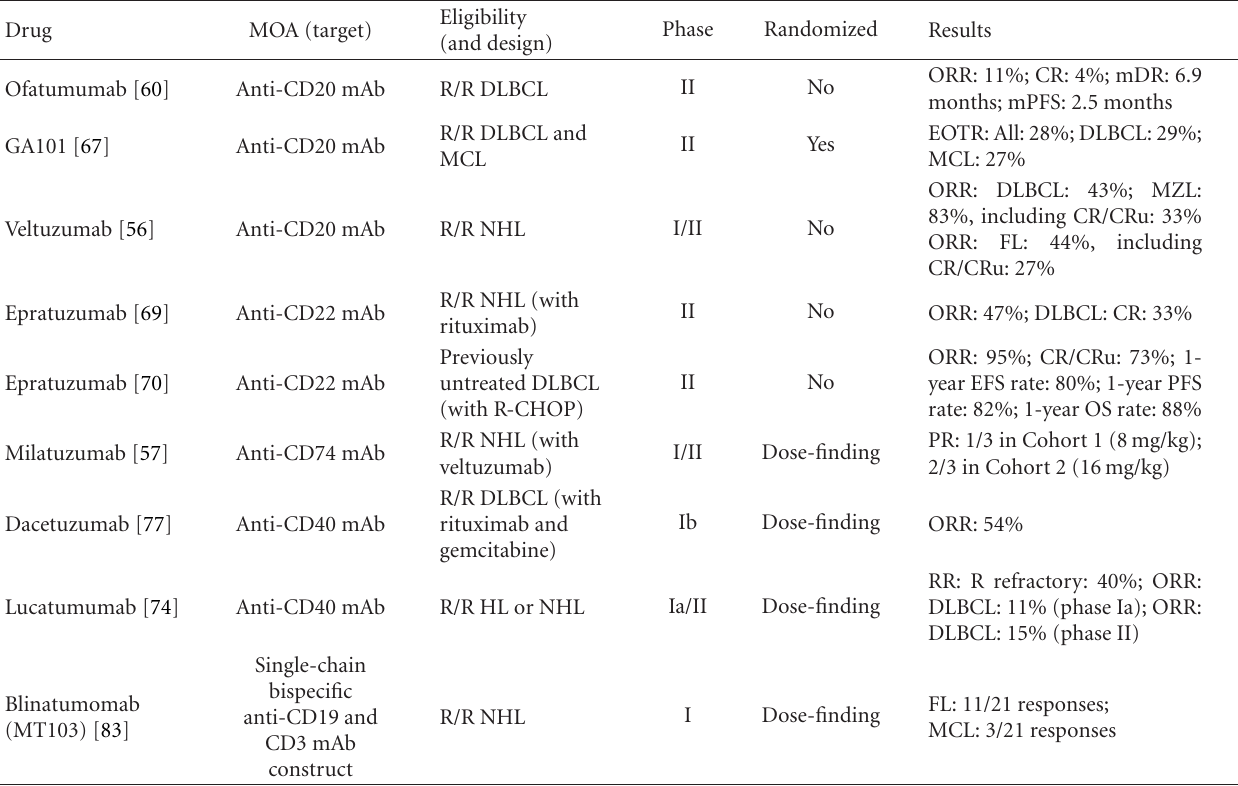
Table 2: Therapeutic antibodies in clinical development for the treatment of aggressive NHL. [CR: complete response; CRu: unconfirmed CR; DLBCL: di ff use large B-cell lymphoma; EFS: event-free survival; EOTR: extent of tumor resection; FL: follicular lymphoma; HL: Hodgkin lymphoma; mAb: monoclonal antibody; MCL: mantle cell lymphoma; mDR: median duration of response; MOA: mechanism of action; mPFS: median progression-free survival; MZL: marginal zone B-cell lymphoma; NHL: non-Hodgkin lymphoma; ORR: overall response rate; OS: overall survival; PFS: progression-free survival; PR: partial response; R-CHOP: cyclophosphamide,